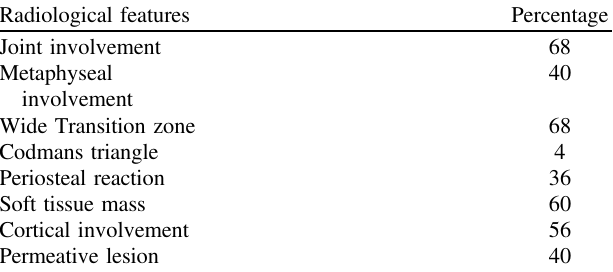
Table 1. Percentage of each radiological feature observed by the musculoskeletal radiologist and orthopedic